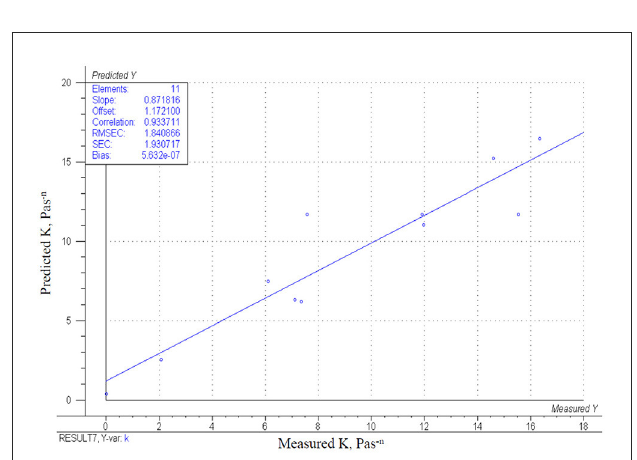
FIGURE3 Correlation of the obtained model and the measured results for the change in K.